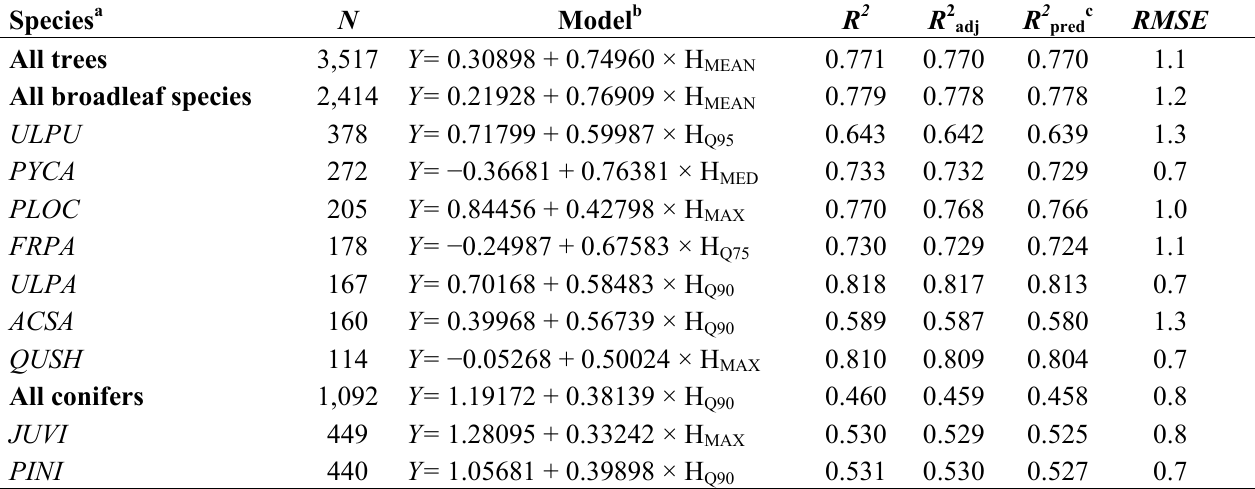
Table 9. Results of regression analysis of crown radius with